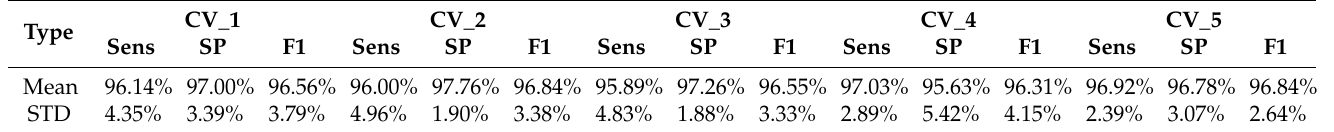
Table 18. Classification performance acquired with 5-fold cross-validation for Sens, Sp, and F1